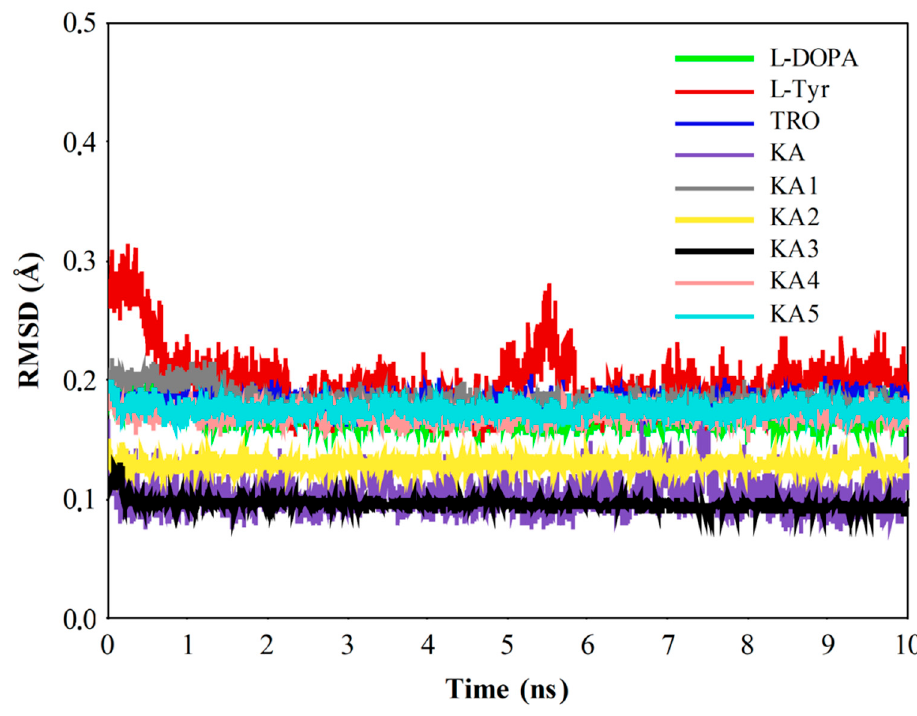
Figure 6. Root-mean-square deviation (RMSD) plot of tyrosinase (TYR) systems during 10 ns of molecular dynamic (MD) simulations.